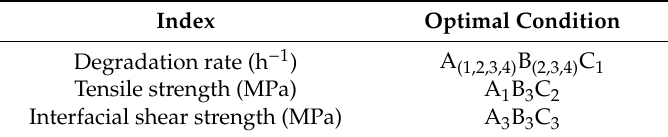
Table 8. Primary optimization of process conditions.